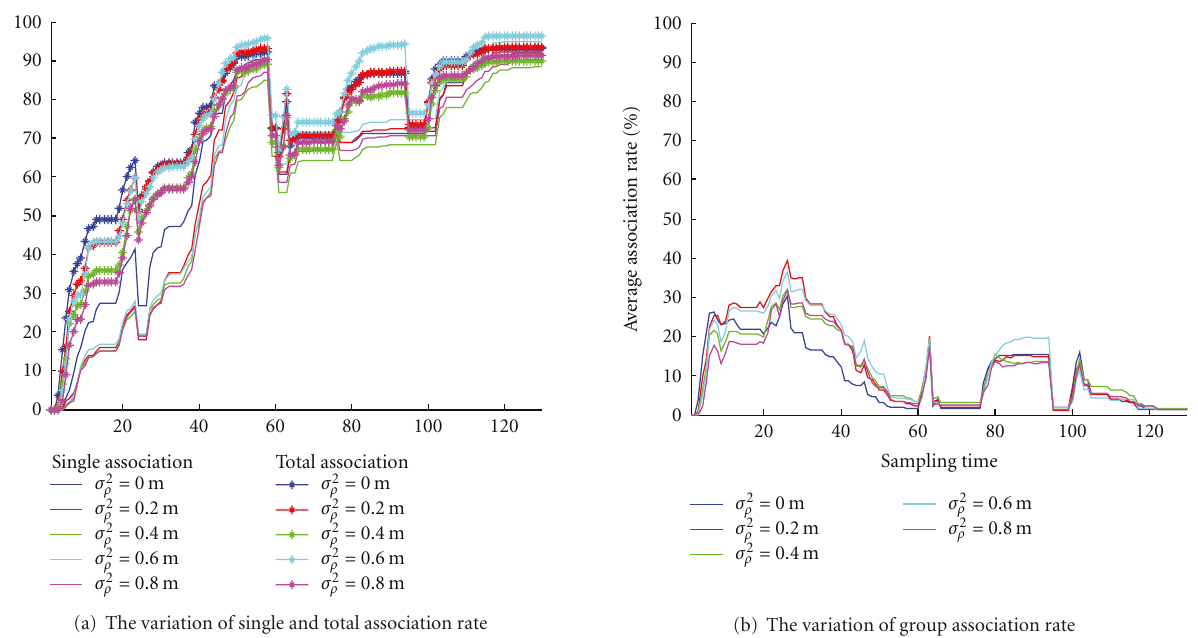
Figure 18: The simulation result of the association performance according to the variance of the modeled region for Figure 17.